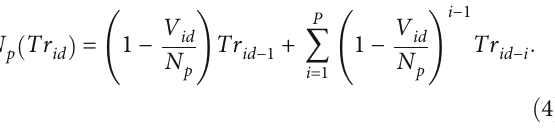
(refer to Figure 2). The correlating dimensional features